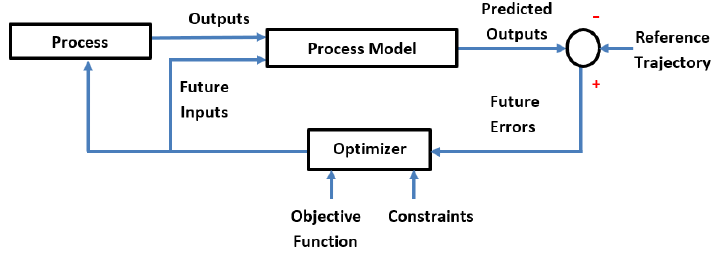
Figure 1. General model predictive control (MPC) control flow